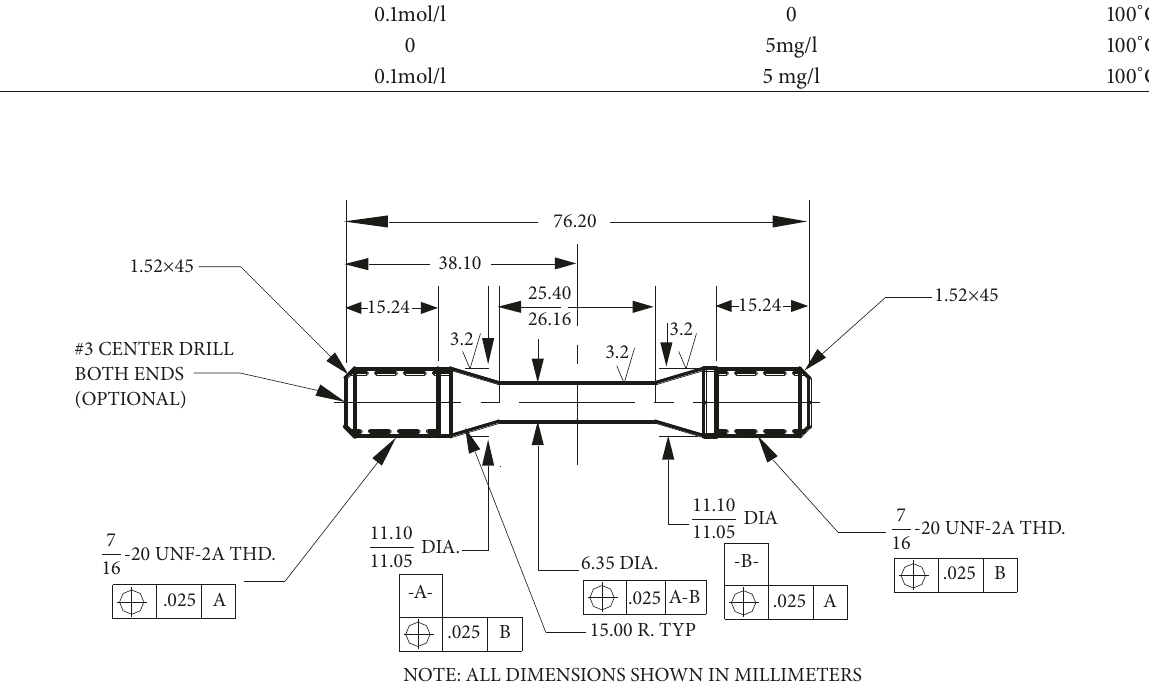
Figure 1: Round bar specimen used in the tensile experiments (all dimensions are in millimeters).